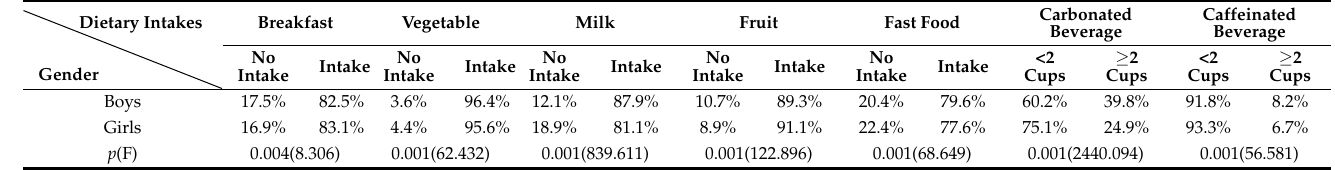
Table 4. Associations of dietary intakes with gender.